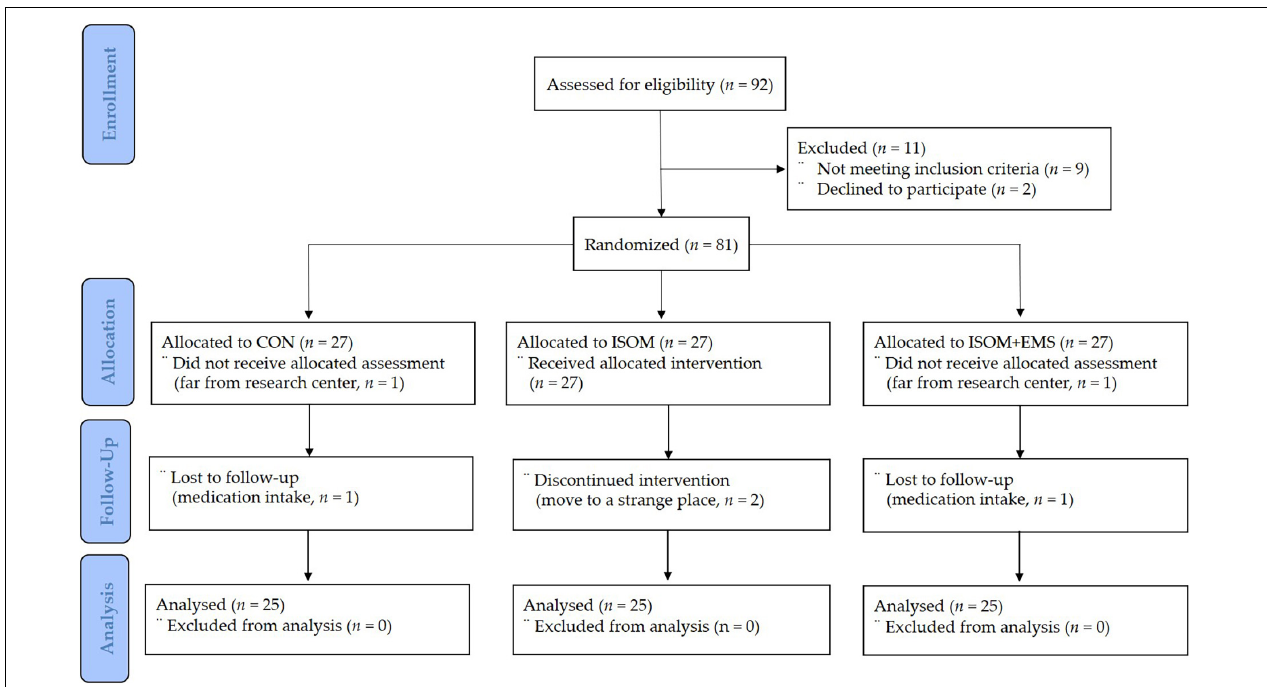
FIGURE 1 | Participants’ allocation (consolidated standards for reporting of trials flow diagram). CON, control group; ISOM, isometric exercise group; ISOM + EMS, isometric exercise + electrostimulation